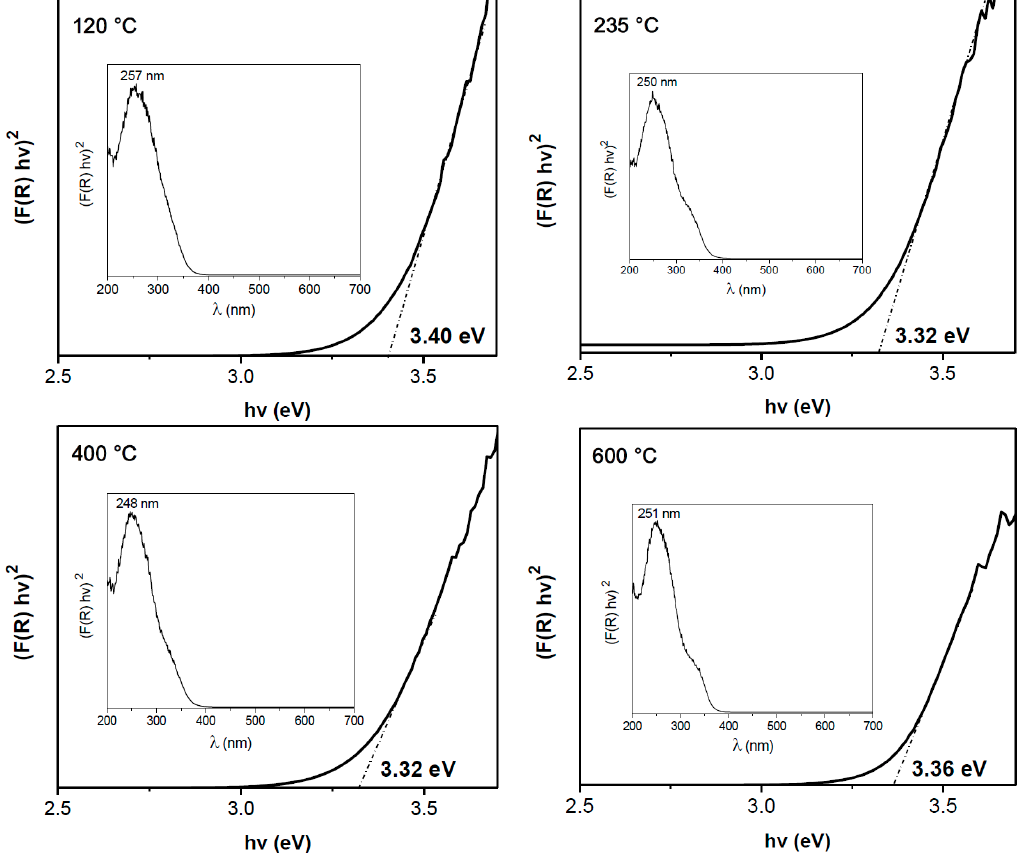
Figure 9. Cont Figure 9. Cont.